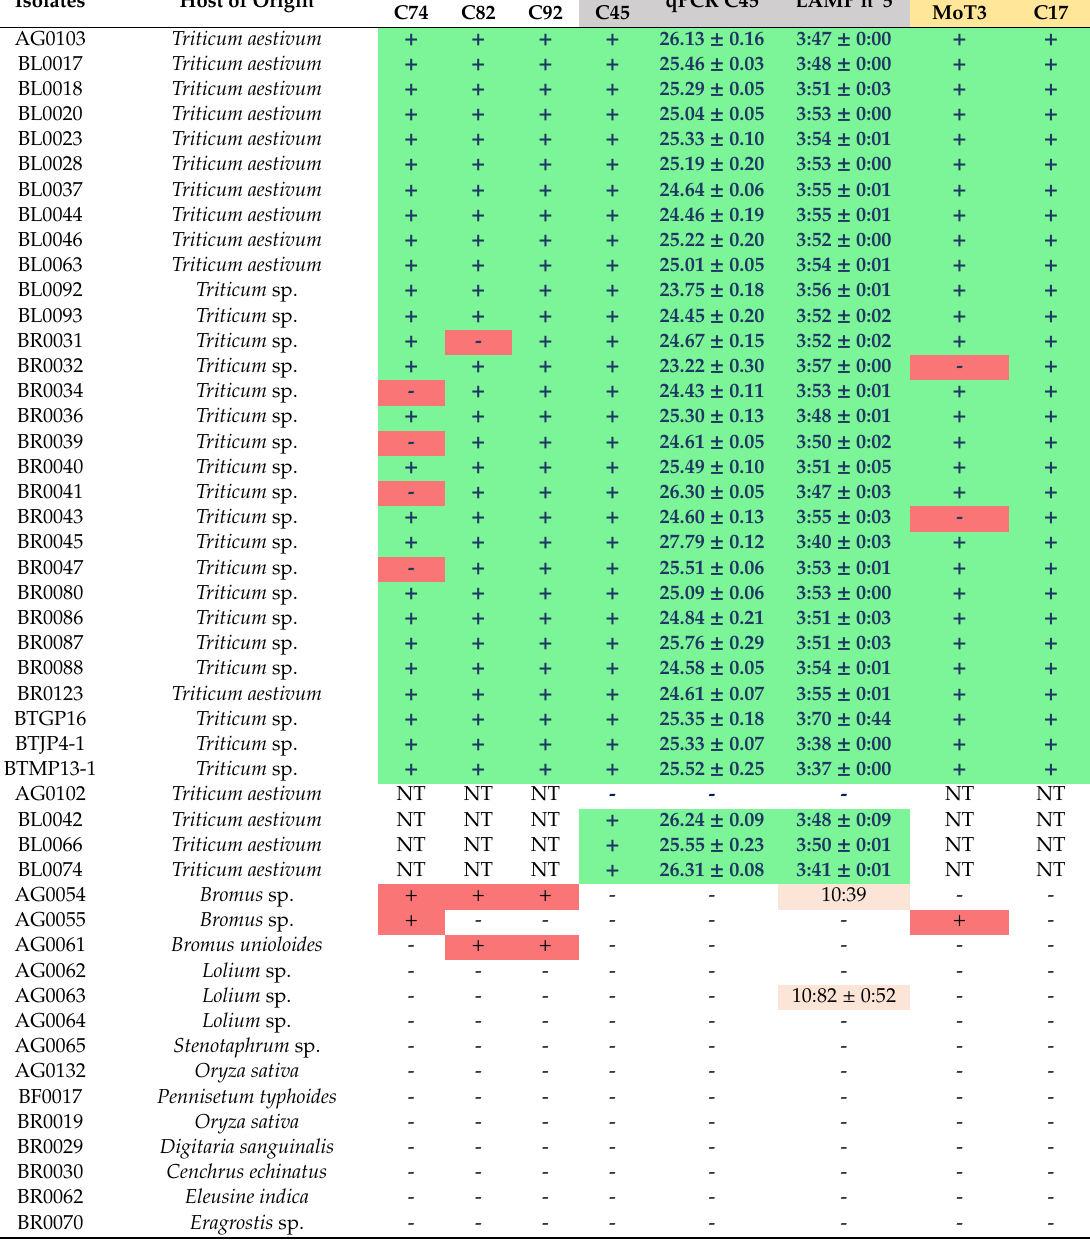
Table 1. Polymerase chain reaction (PCR), quantitative polymerase chain reaction (qPCR), and loop-mediated isothermal amplification (LAMP) primer screening using a large DNA panel. qPCR tests MoT3 [3] and C17 [20] are included for comparison. PCR results yielded positive ( + ) or negative (-) reaction, mean Ct values and standard deviation are indicated for qPCR and times for positive reaction are reported for LAMP. Isolates in red belong to other fungal species: Microdochium nivale (LSV M 641); Fusarium tricinctum (LSV M 723, LSV M 860); Fusarium proliferatum (LSV M 702, LSV M 706); Fusarium poae (LNPV 269, LSVM 861); Fusarium graminearum (LSV M 273, LSV M 811, LSV M 813); Fusarium culmorum (LSV M 662, LSV M 694, LSV M 697); Fusarium avenaceum (LSV M 642, LSV M 859, LSV M 863); Alternaria tenuissima (CBS918.96, CBS965.95) and Alternaria alternata (BRIP46550). Expected amplifications (positive results) are highlighted in green, late false positive amplification are highlighted in light red, whereas other false positive results as well as false negative results are highlighted in dark red. NT: not